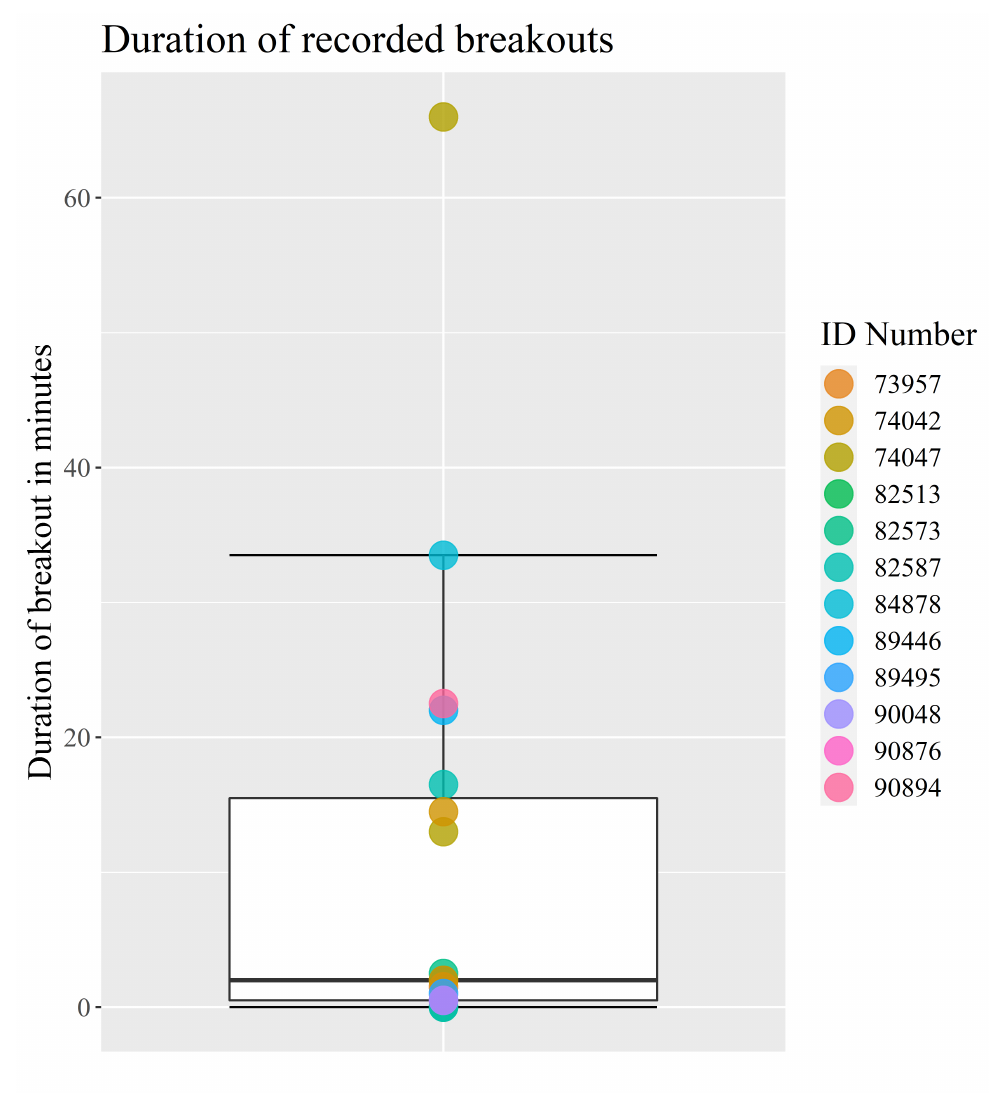
Figure 3. Boxplot of the duration of time spent outside the virtual enclosure for each breakout event during the 89-day period. The points represent each breakout and the colours indicate the escaped individual’s ID number. The boxplot shows min, Q1, median, Q3 and max. Outliers are calculated as 1.5 times IQR. The points are mainly clustered between 0 and 2 min with a few breakouts ranging from 13 to 33.5 min and a single breakout being an outlier at 66